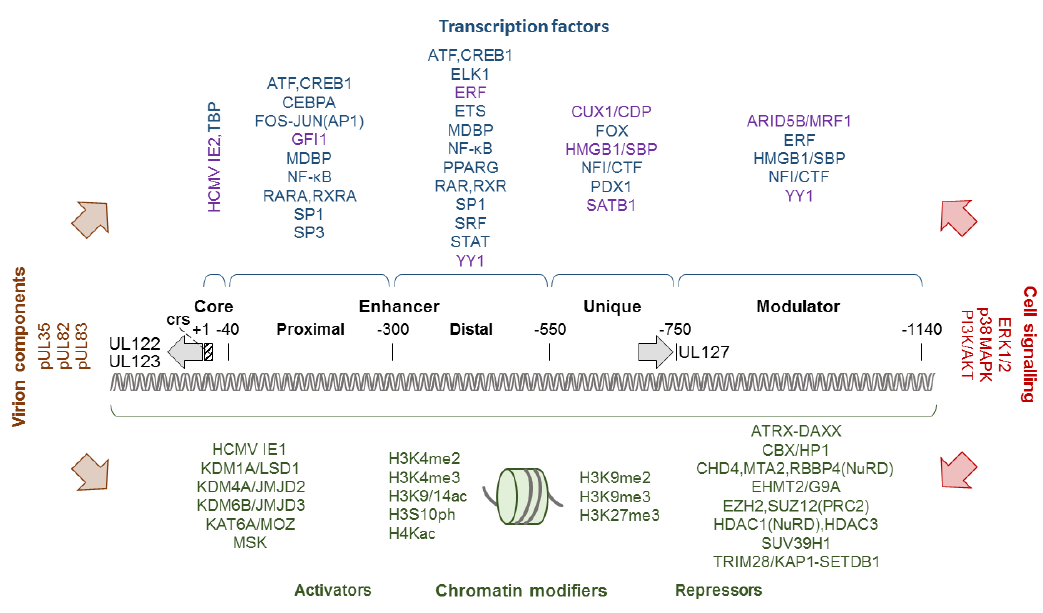
Figure 1. Organisation of the human cytomegalovirus (HCMV) major IE enhancer and promoter (MIEP) and select protein factors involved in its regulation. The MIEP is composed of a core promoter containing a TATA-box and the crs that mediates repression by IE2, an enhancer with proximal and distal parts, a unique element and a modulator. Nucleotide positions relative to the transcription start sites and the direction of transcription (grey arrows) are indicated. “Leftward” transcription results in mRNAs encoding the IE1 and IE2 proteins (“rightward” transcription results in uncharacterized mRNAs containing the UL127 open reading frame). Transcription factors known or predicted to bind to the individual parts of the MIEP are shown above (repressors are shown in purple). Chromatin modifiers and histone tail modifications reported to activate or repress the MIEP are shown below. A few examples of virion components and cell signalling pathways known to activate the MIEP are shown at the left and right side, respectively, of the diagram. ARID5B/MRF1, AT-rich interaction